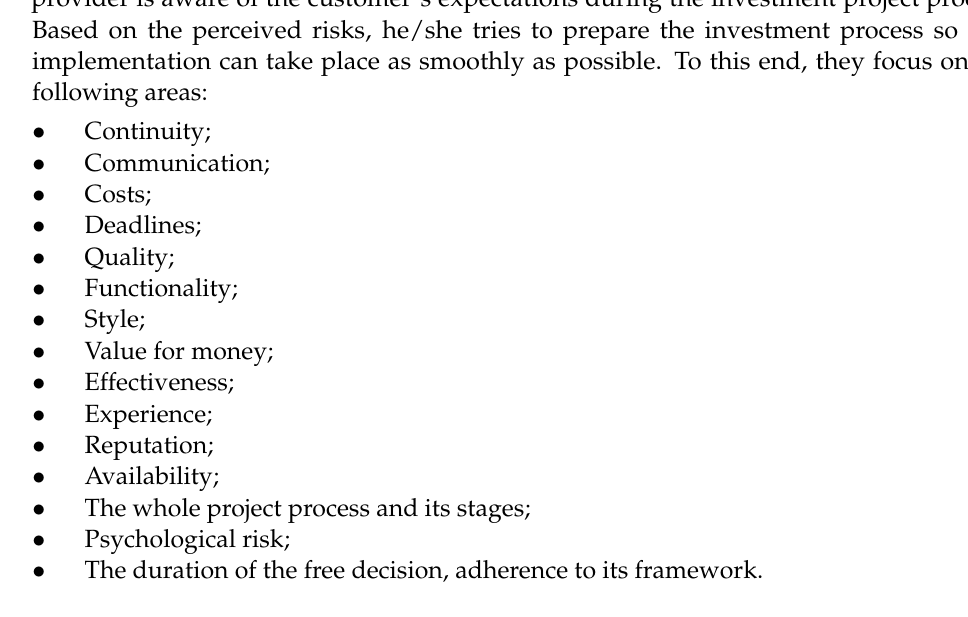
Table 4. Service project considerations determining the reduction of perceived risks in construction project investments. Source: authors’ own research, 2018. N = 52